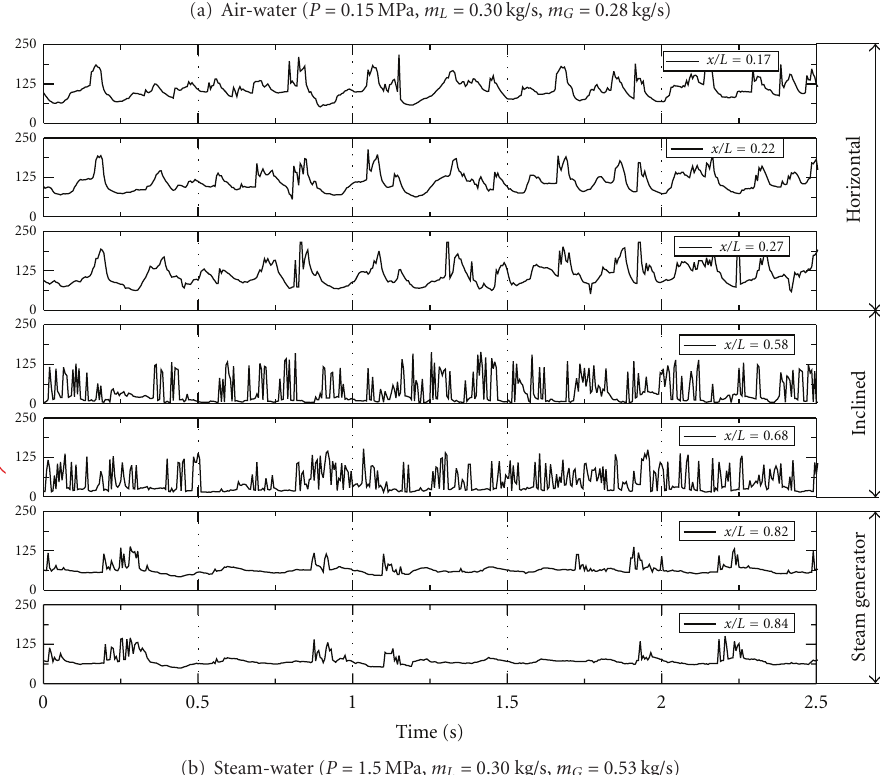
Figure 7: Time variation of water level inside the hot leg channel during